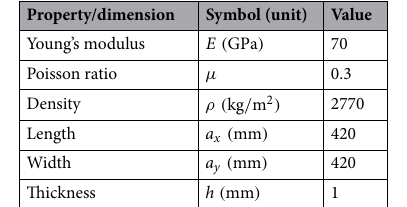
Table 1. Properties and dimensions of the aluminium material utilized for the present